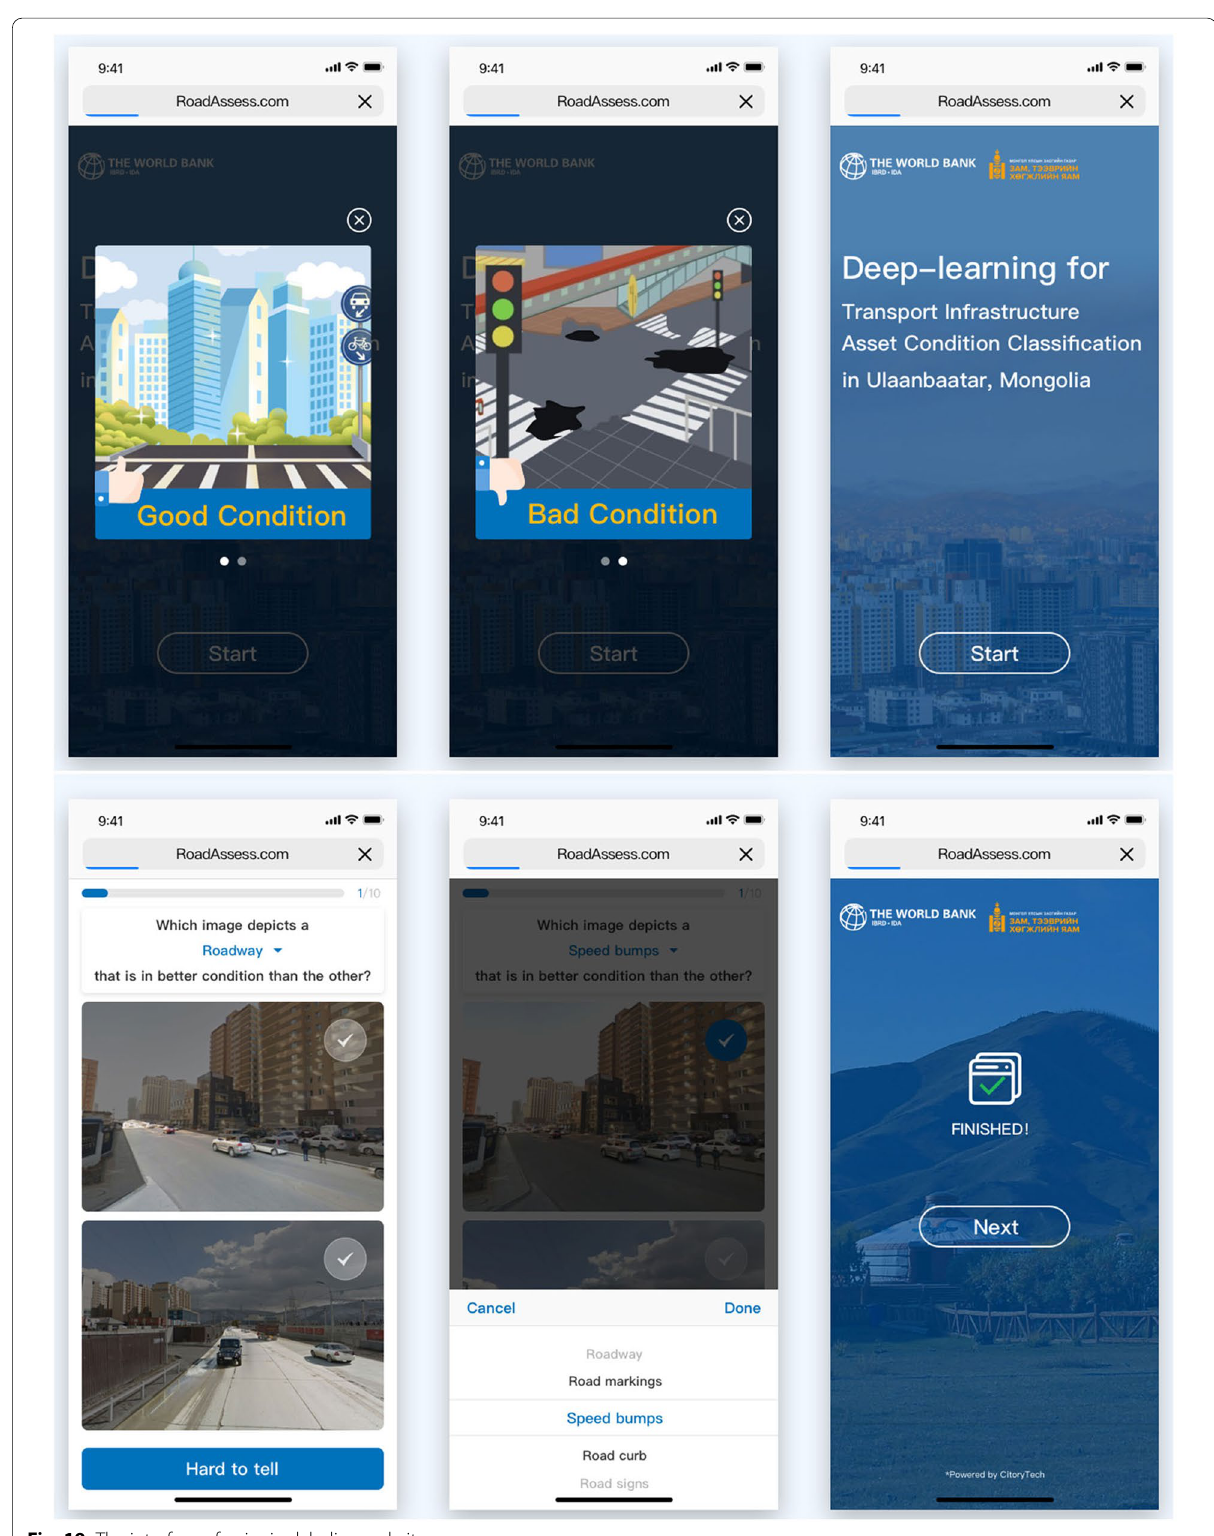
Fig. 19 The interface of pairwise labeling